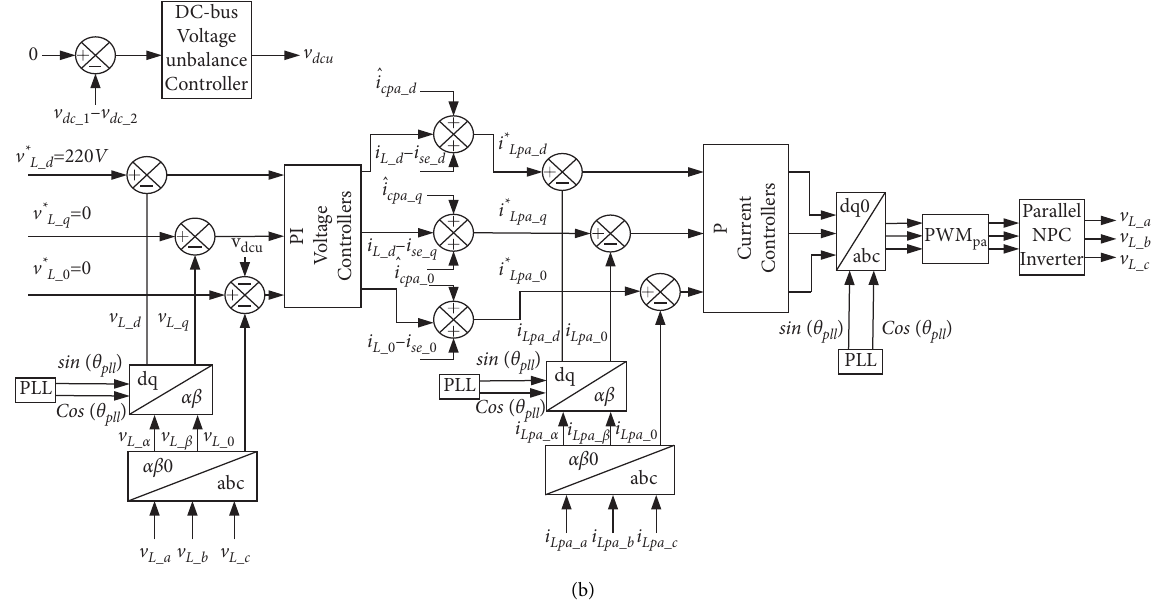
Figure 2: Signal flow diagrams of control loops of the series and parallel converters. (a) Series currents reference generation and control loops; (b) parallel reference voltages generation and control